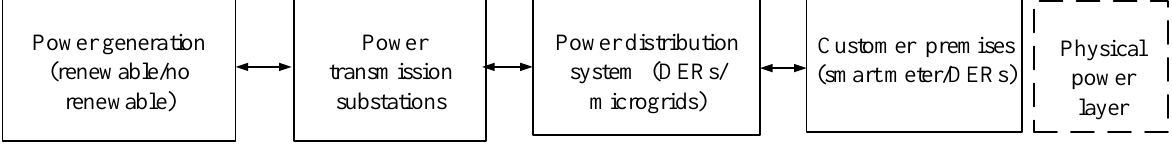
Figure 2. System architecture for the smart grid paradigm.